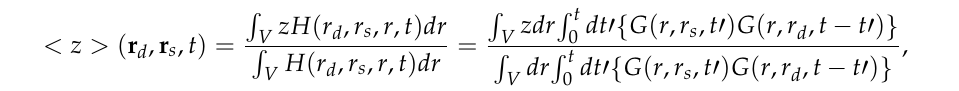
Figure 6. Distributions of the time-resolved sensitivity of the reflectance from a homogeneous semi-infinite medium with the source-detector (SD) distance, ρ , of 30 mm, µ a = 0.01 mm − 1 , and µ s (cid:48) = 0.5 mm − 1 for different delays of the time windows of 0.86 ns, 1.66 ns, and 2.46 ns from left to right. Reproduced from Reference [30].